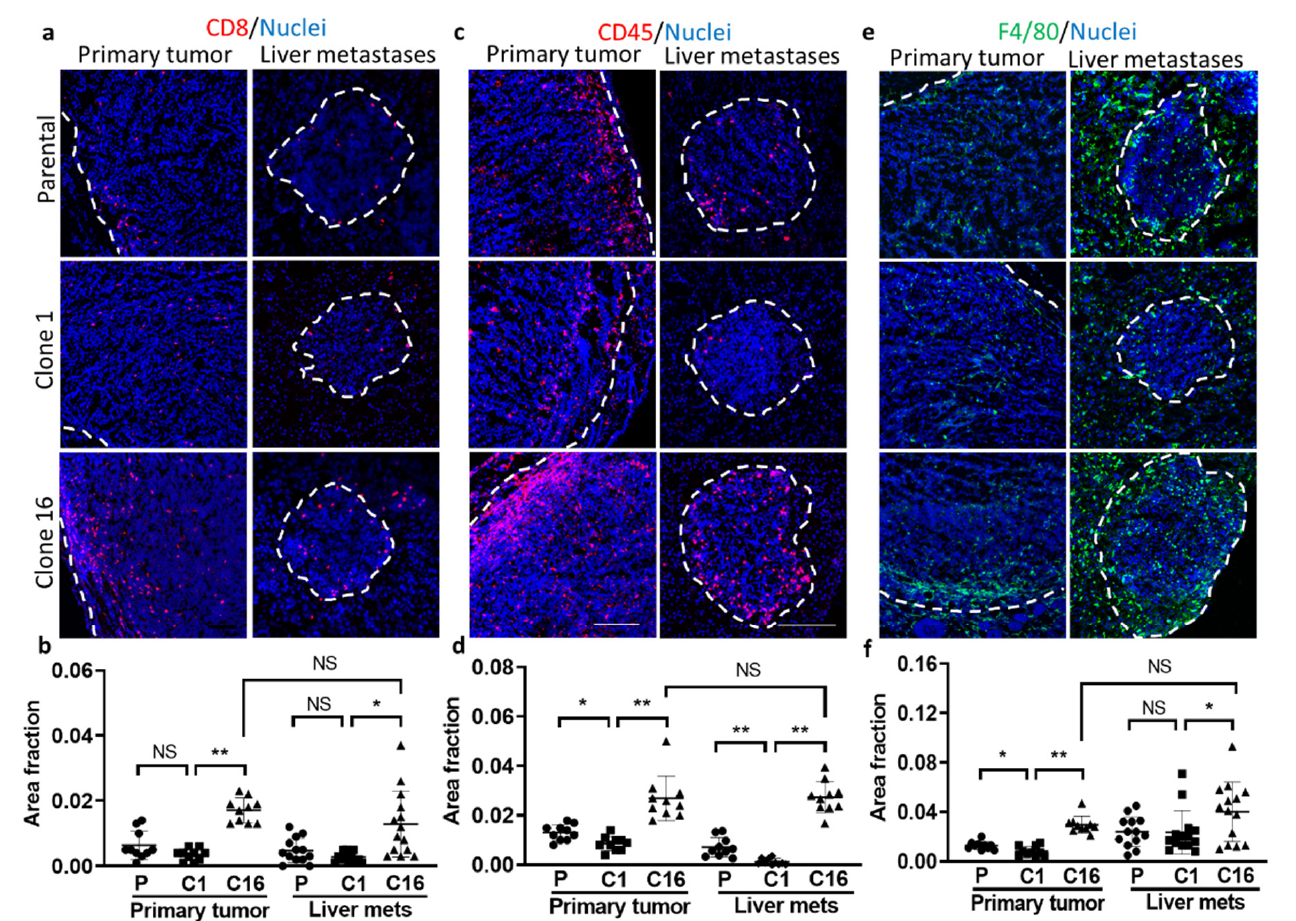
Figure 6. Evaluation of immune microenvironment in parental-, clone-1-, clone-16-derived primary tumor and liver metastases. Immunofluorescence imaging of ( a ) CD8, ( c ) CD45, and ( e ) F480 in both primary and liver metastases. Area fraction of ( b ) CD8, ( d ) CD45, and ( f ) F4/80 in parental-, clone-1- and clone-16-derived primary tumor and liver metastases are shown (* p < 0.05; ** p < 0.001; NS: no significant difference). Scale bar, 100 µm.